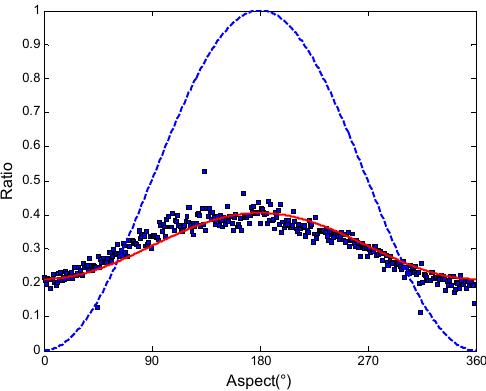
Figure 9. Graph of the damaged pine distribution ratios in different aspect values. The abscissa was slope value and the ordinate was the ratio of severely damaged pine trees (with RVI < 4) in a specific aspect value to all pine trees in the same aspect value in the middle damaged year (2000). A total of 360 points were counted.